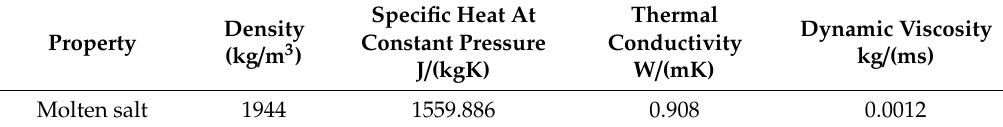
Table 3. Properties of molten salt (Hitec)